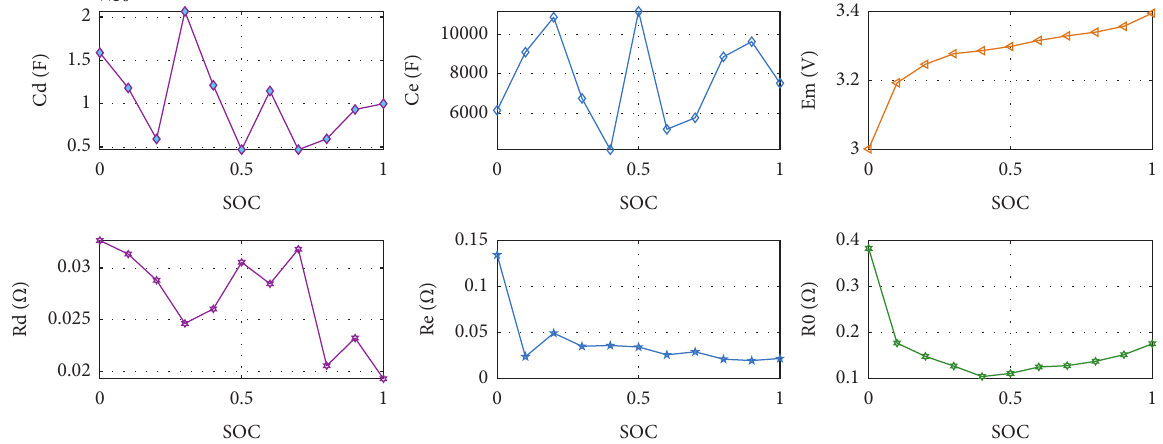
Figure 13: Model parameter estimation result.